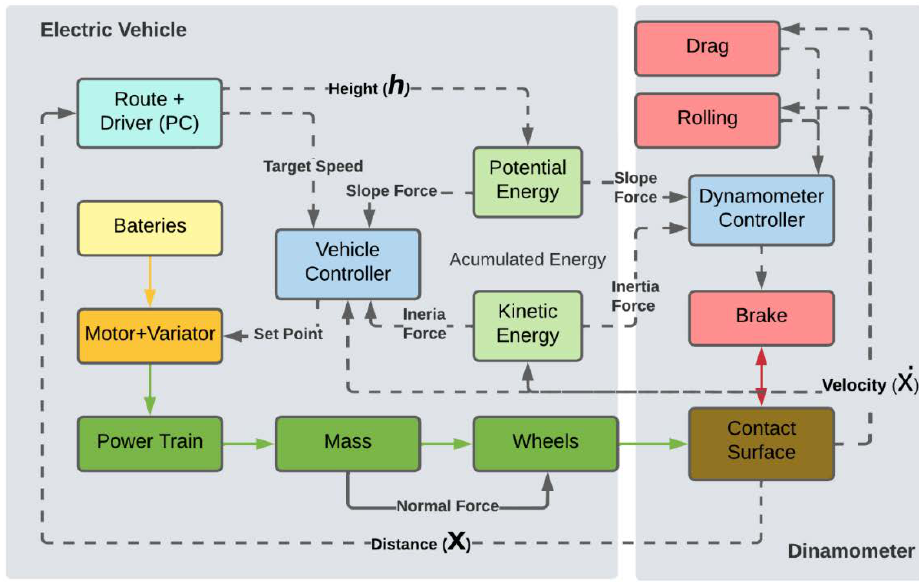
Figure 5. Energy and information flows in the dynamometer.